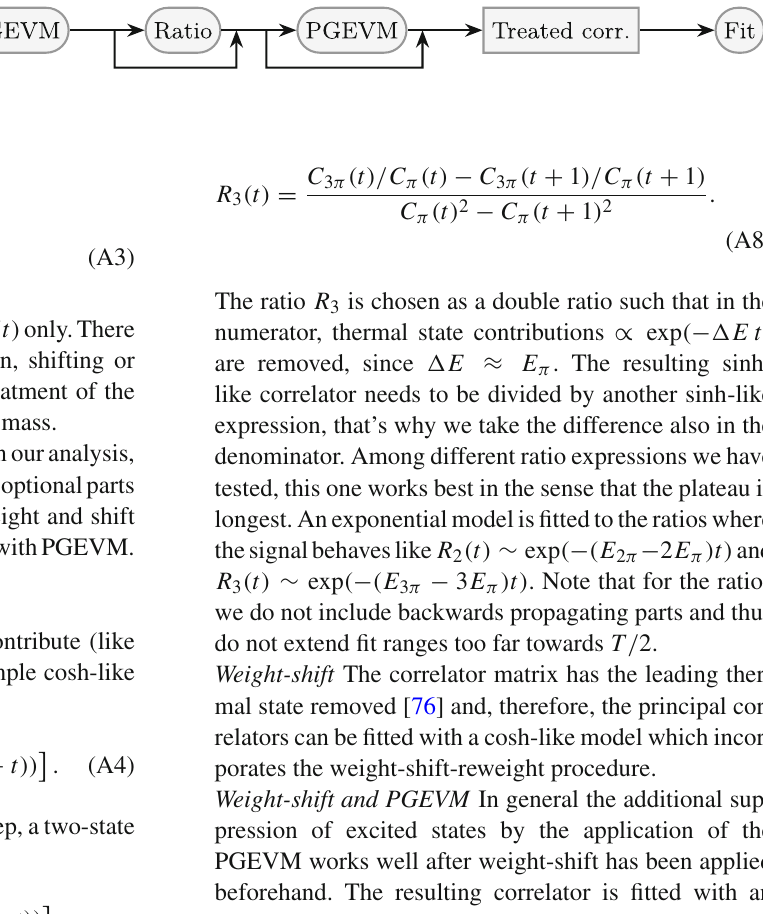
Fig. 6 Treatment of correlator matrices before fitting